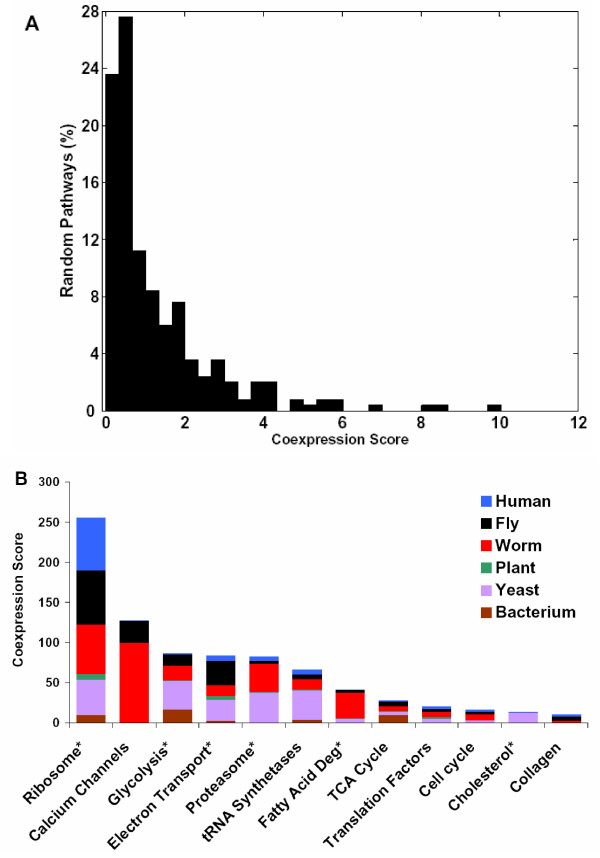
Performance of the search engine using data from separate organisms. A. Random control pathways were scored by the GeneRecommender in all six organisms, and the coexpression score was computed from the search orderings as the sum of the precision at the 50% recall rate across all six organisms. B. Precision scores of the top-scoring pathways from the GenMAPP database. Each bar corresponds to a single pathway. Colored segments indicate the precision at the 50% recall rate for each organism. The height of each bar corresponds to the pathway's coexpression score. Asterisks indicate names that were modified to fit on the plot: Ribosome, Cytoplasmic Ribosomal Proteins; Glycolysis, Glycolysis and Gluconeogenesis; Electron Transport, Electron Transport Chain; Proteasome, Proteasome Degradation; Fatty Acid Deg, Fatty Acid Degradation; Cholesterol, Cholesterol Biosynthesis.